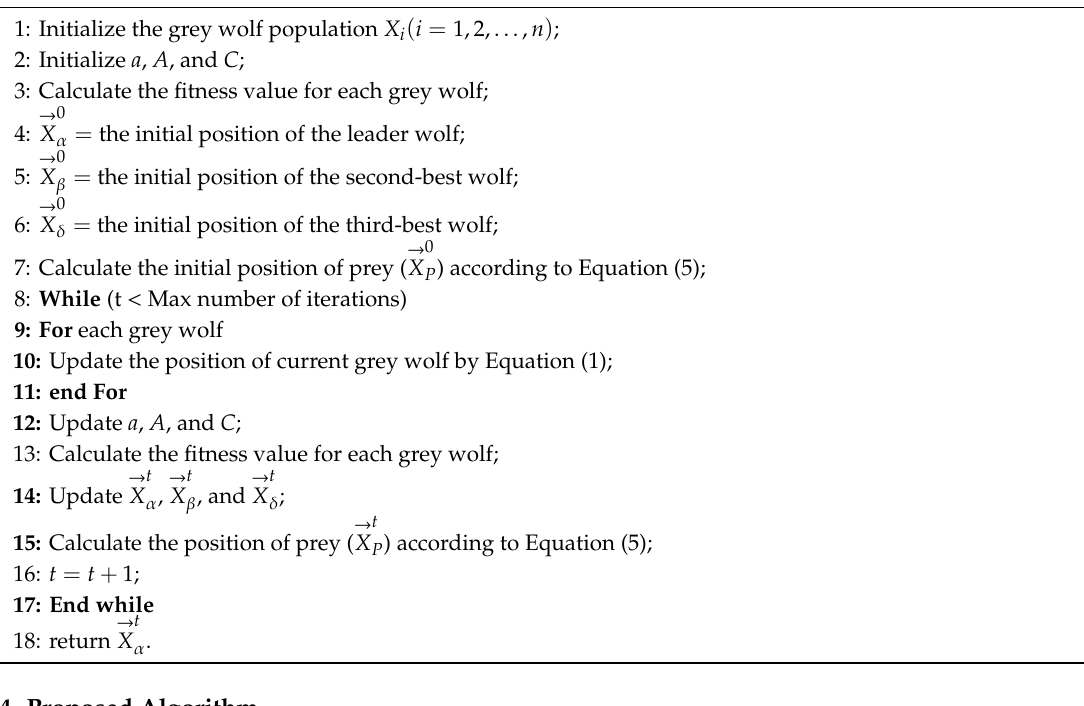
Algorithm 1 GWO